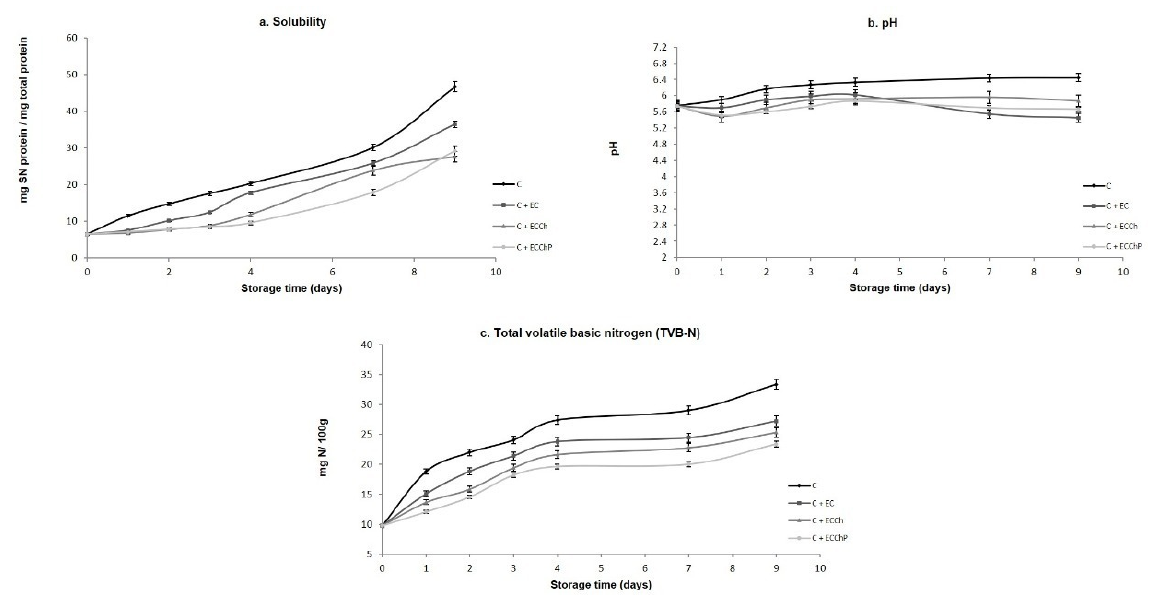
Figure 4. Changes in the physicochemical properties of common carp ( Cyprinus carpio ) fillets stored at 4 °C for nine days. Values are the mean of three replicates. C = uncoated fillet (control); C + EC = carp fillet with edible coating; C + ECCh = carp fillet with chitosan-based coating; C + ECChP = carp fillet with chitosan-based coating enriched with peppermint extract; SN = supernatant.